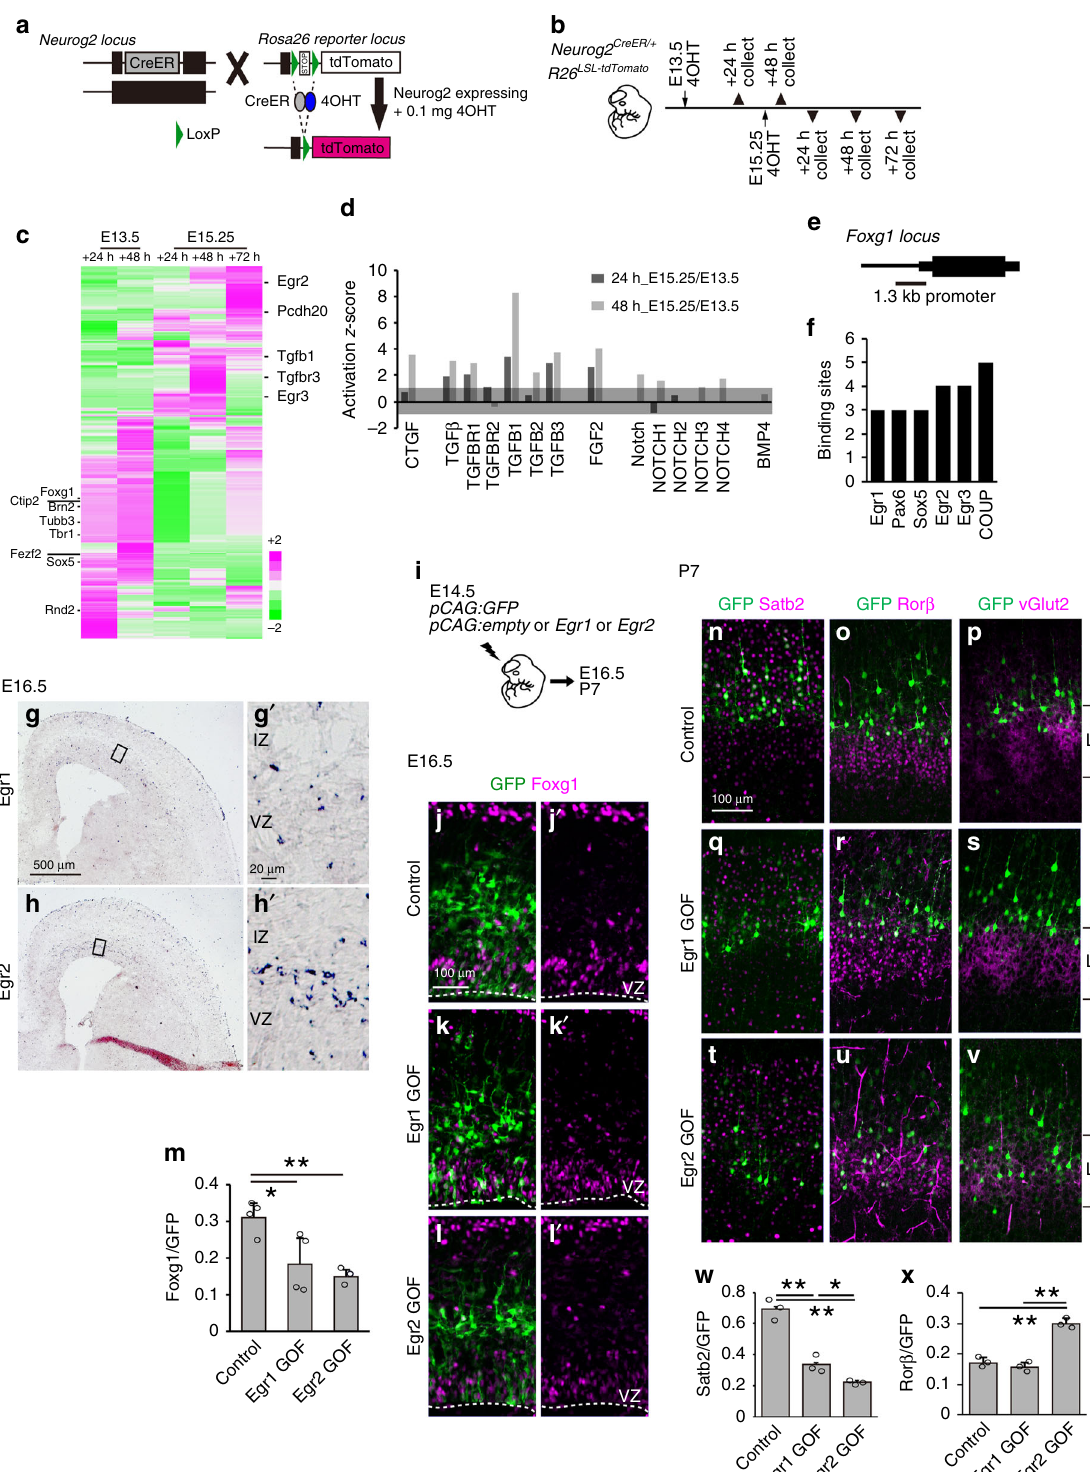
(i.e., Foxg1 conditional knockdown, Supplementary Fig. 8c, d) and the spatiotemporal expression dynamics of Egr2 (Fig. 8h, h ′ ), Foxg1 and COUP-TFI (Fig. 1e – e ″ ), together with the reported NeuroD1 expression 45 , Neurog2 expression 46 , and transcriptomic pro fi le during neurogenesis (Supplementary Fig. 11) 47 , the timing of high-Egr2 and low-Foxg1 expression coincides with Tbr2 expression prior to NeuroD1 peak expression (Supplementary NATURE COMMUNICATIONS| (2019) 10:3581